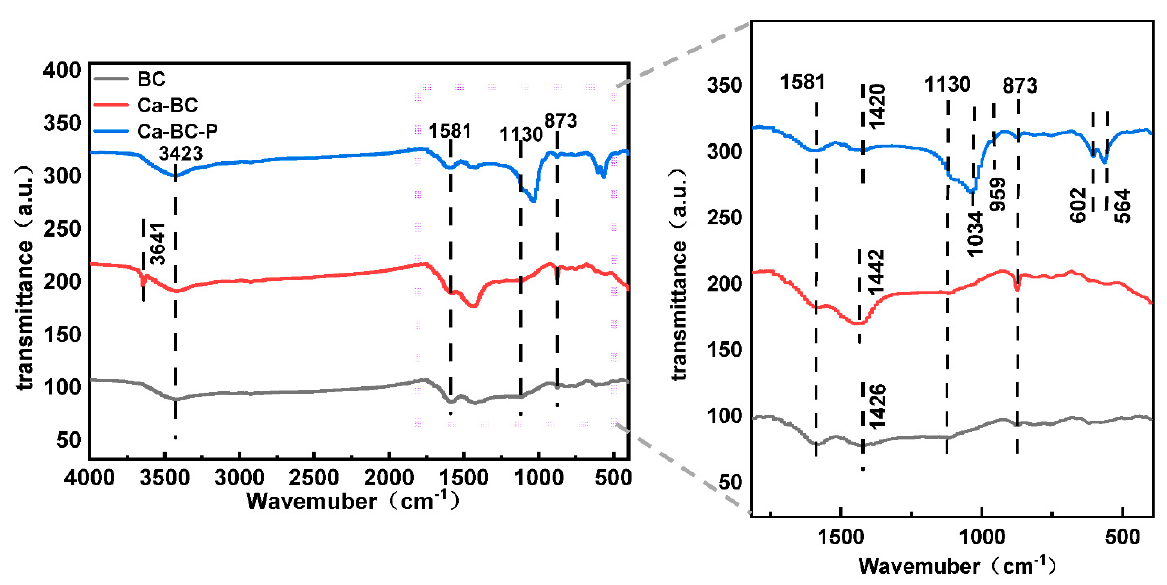
Figure 6. FTIR spectra of BC and Ca-BC before and after phosphorus adsorption.